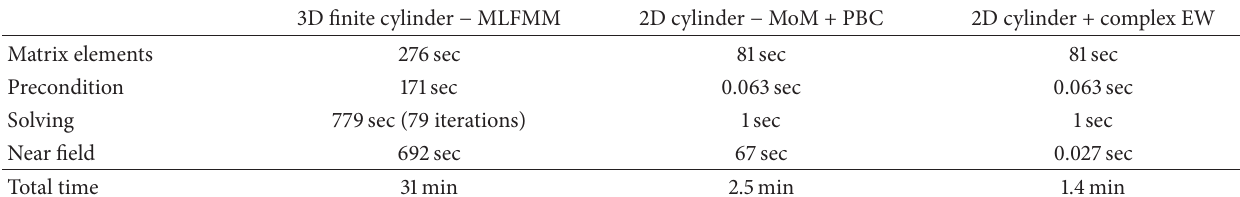
Table 1: Computation time summary for Figures 3(a), 3(b), and 7(b).